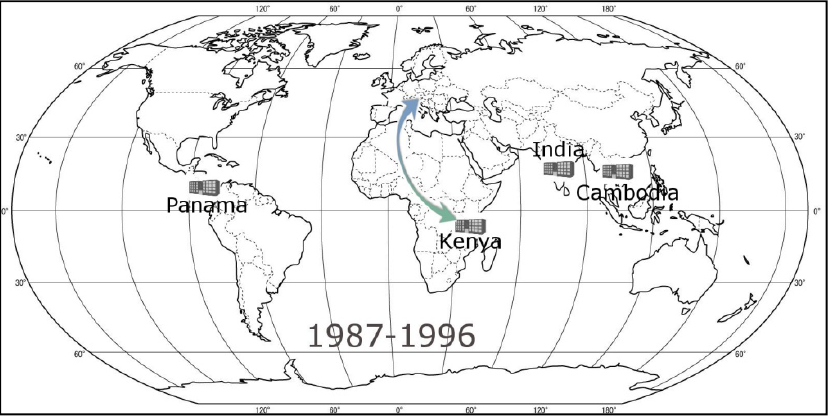
Figure 4. The change in fourth warehouse location from 1977–1986 period to 1987–1996